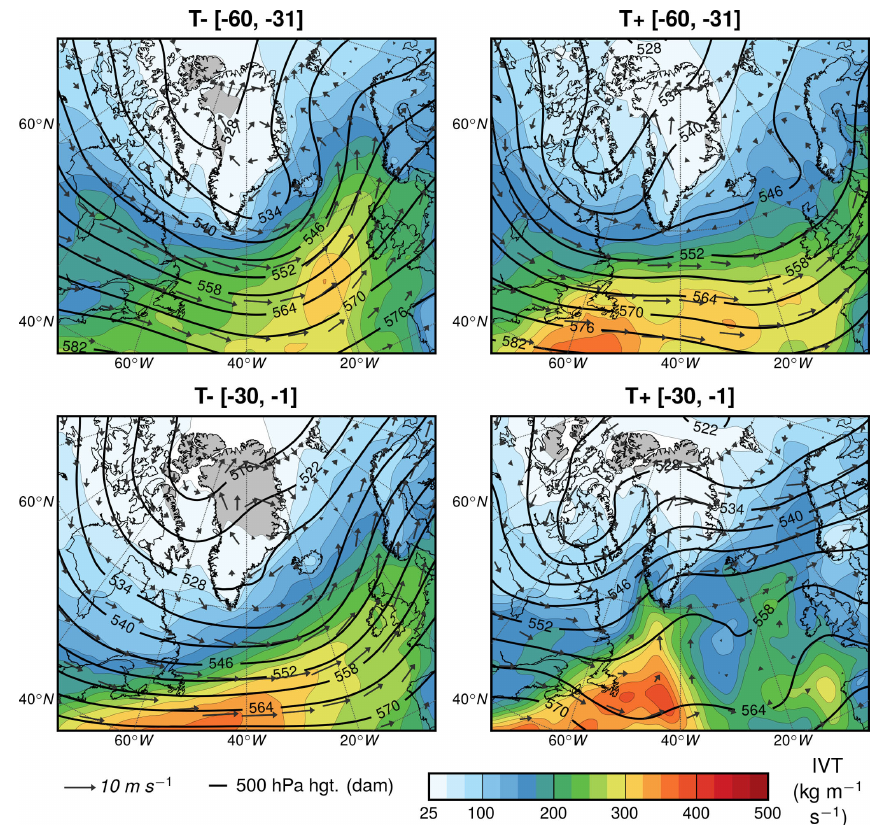
Figure 9. Composite plots of integrated vapor transport (IVT), 1000–700hPa winds, and 500hPa GPH from ERA-Interim for T + and T − events at KAN_B for the two periods preceding the Baffin Bay date of sea ice advance